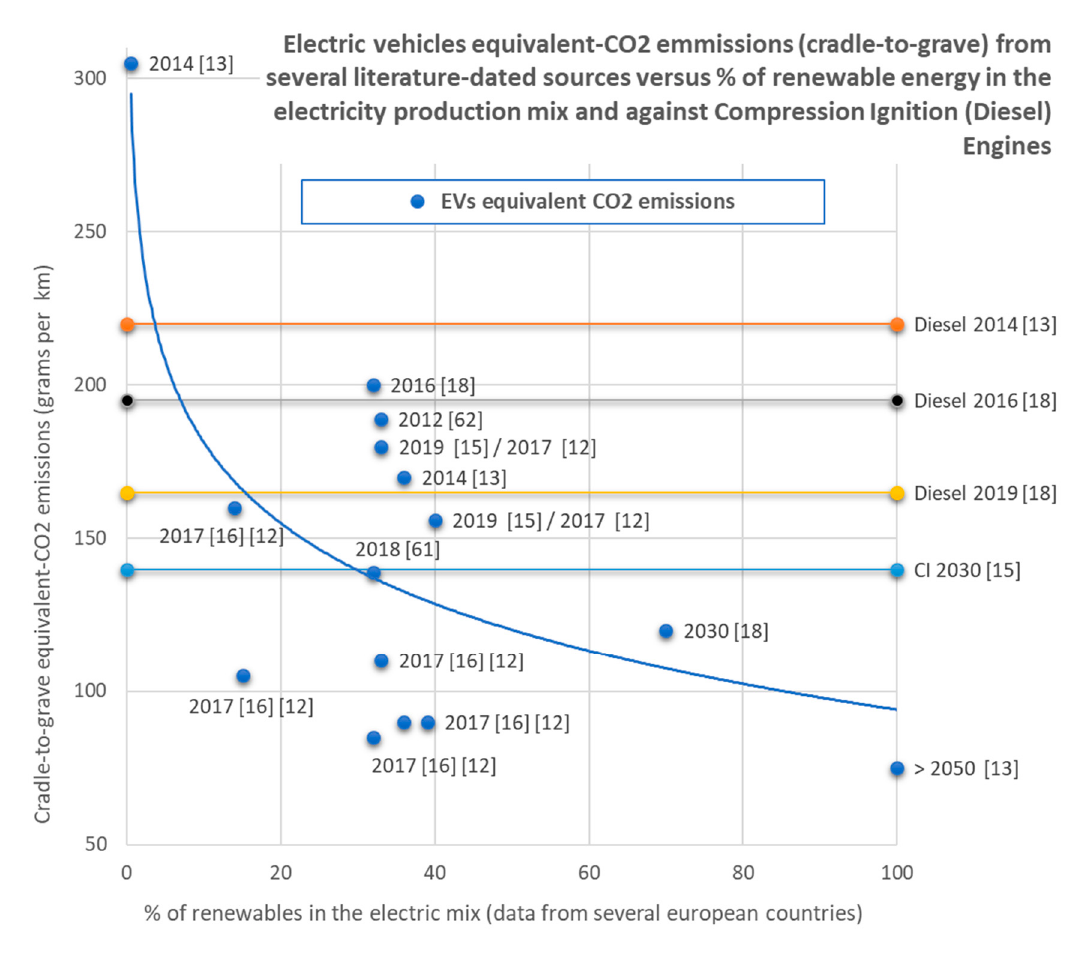
Figure 6. Equivalent life-cycle CO 2 emissions of electric vehicles as a function of the percentage of renewables in the electric energy production mix. Comparison with compression ignition (CI) or diesel engines. Elaborated from the references of this publication.